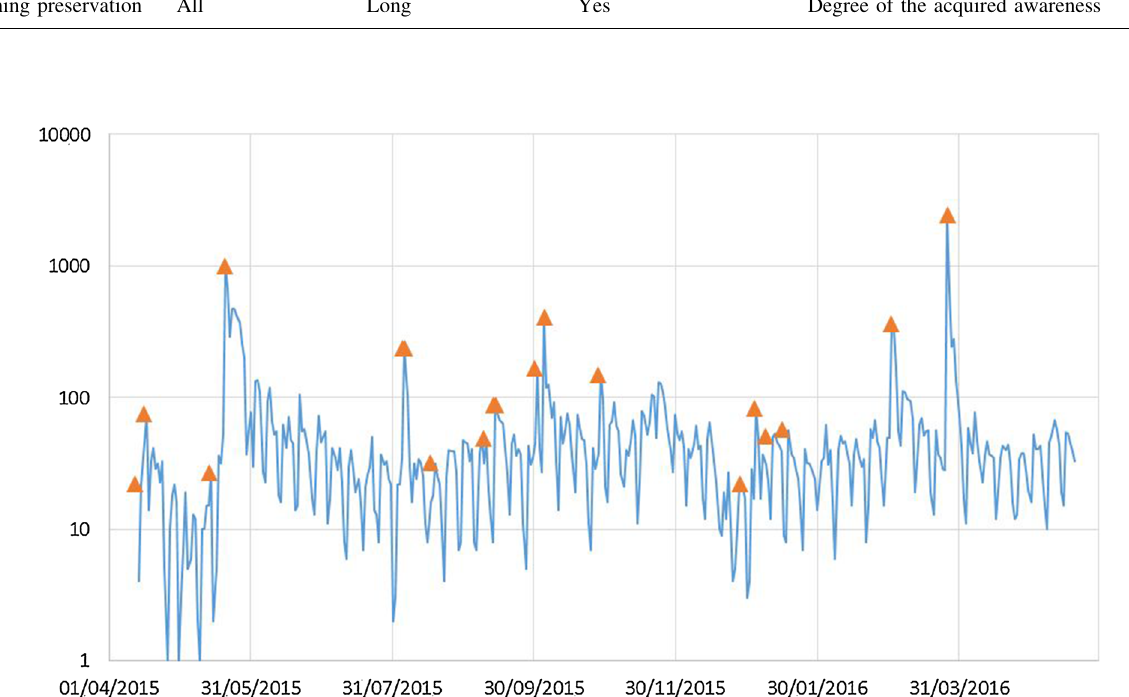
Table 5 Hazard knowledge indicators based on web analytics on a national government platform Indicator Spatial scale Temporal scale Referred to population Meaning Number of sessions All Medium Long Yes Overall increase of the level of information Sessions per day National/Regional Medium Long No Background willingness to know Session peaks National/Regional Short Medium Long No Emotional willingness to know User growth All Medium Long Yes Learning degree All Long Yes Degree of the acquired knowledge Learning preservation All Long Yes Degree of the acquired awareness